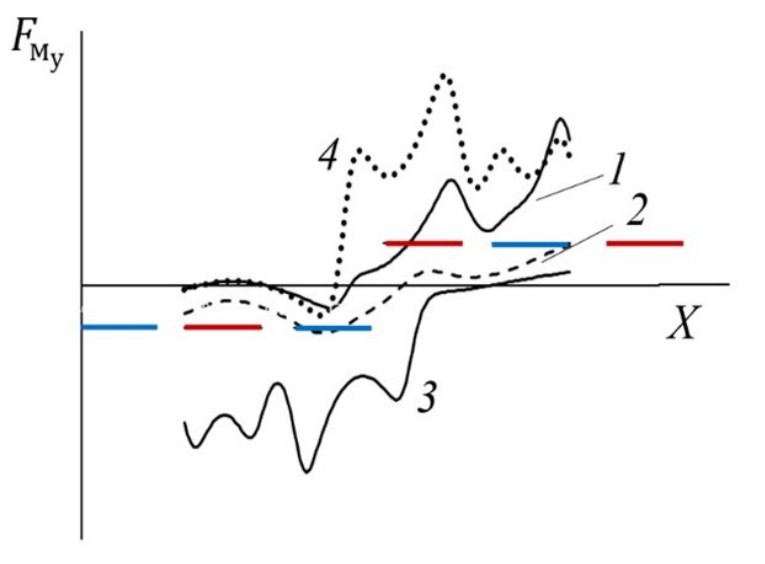
Figure 6. Distribution of F m (1–4) force vertically applied to magnetite particle in the system with y two separators. Horizontal line segments show location of 24 mm wide and 20 mm high magnets with colors indicating their polarities. The distance between the magnets is 30